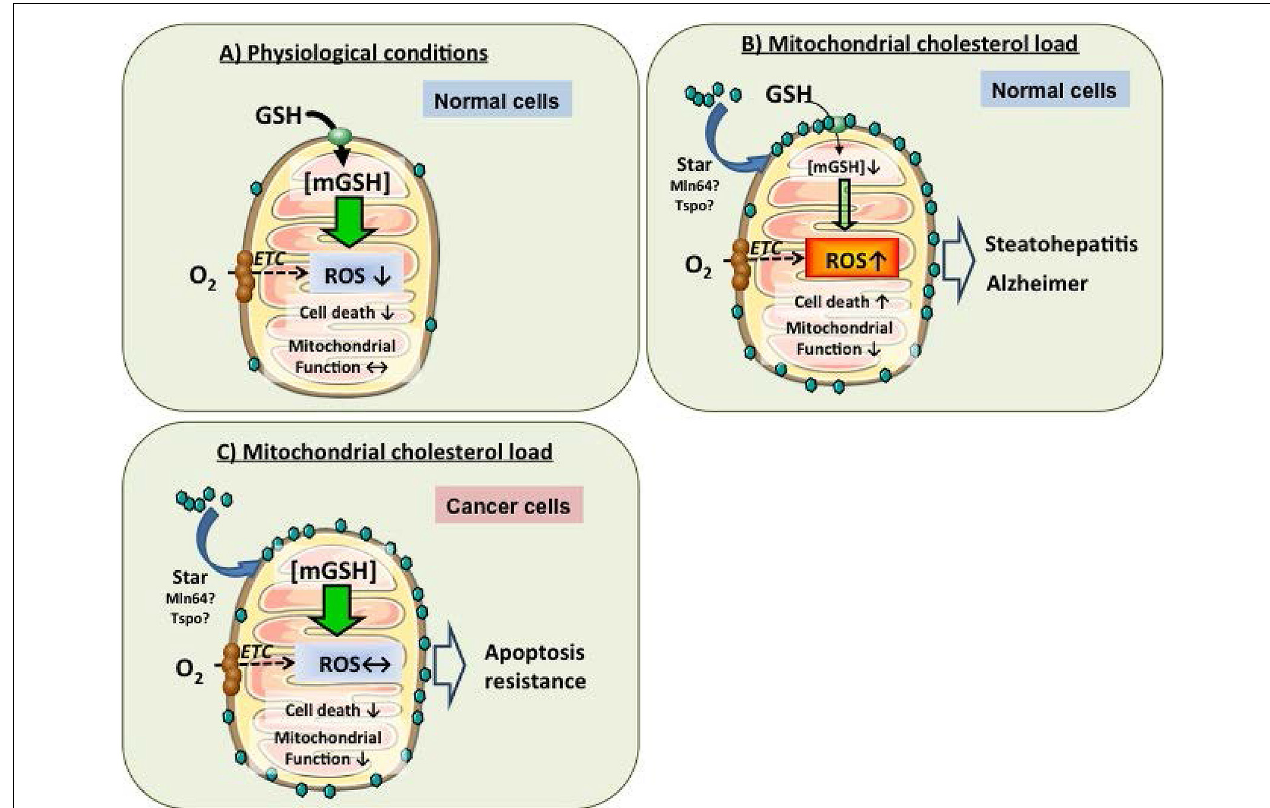
cell death. (C) However, cancer cells exhibit increased cholesterol enrichment of mitochondrial membrane but paradoxically maintain mGSH levels despite changes in membrane physical properties by an as yet uncharacterized mechanism. Increased mitochondrial cholesterol and mGSH protect against mitochondrial membrane permeabilization and cell death.Thus, targeting mitochondrial cholesterol or mGSH may be a novel approach in the treatment of